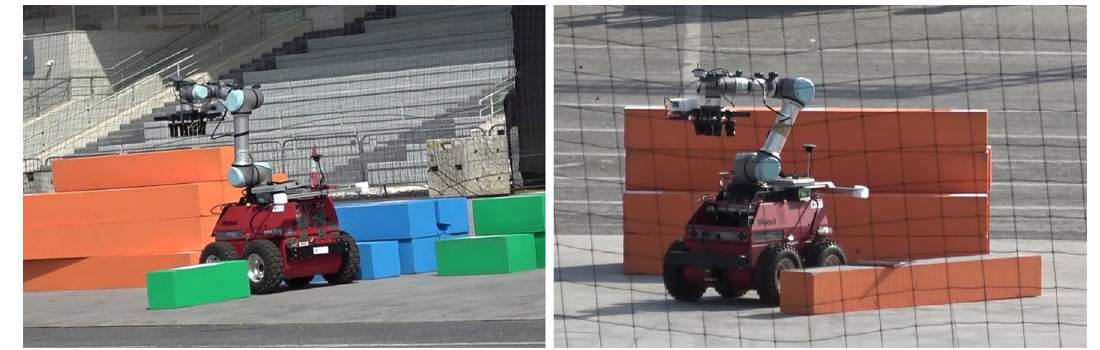
Fig. 8 Snapshot from the actual MBZIRC 2020 competition trials illustrating the real-time path planning and the robust navigation even in the presence of unexpected obstacles